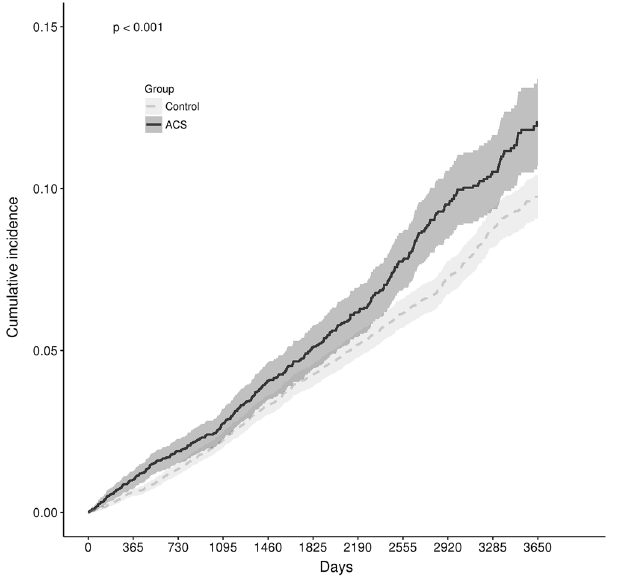
Figure 2. Cumulative incidence of first pneumonia events during the first 10 years after study inclusion. Exposure to ACS was associated with a significantly higher incidence of first pneumonia events during the observation period (log-rank test, p < 0001).